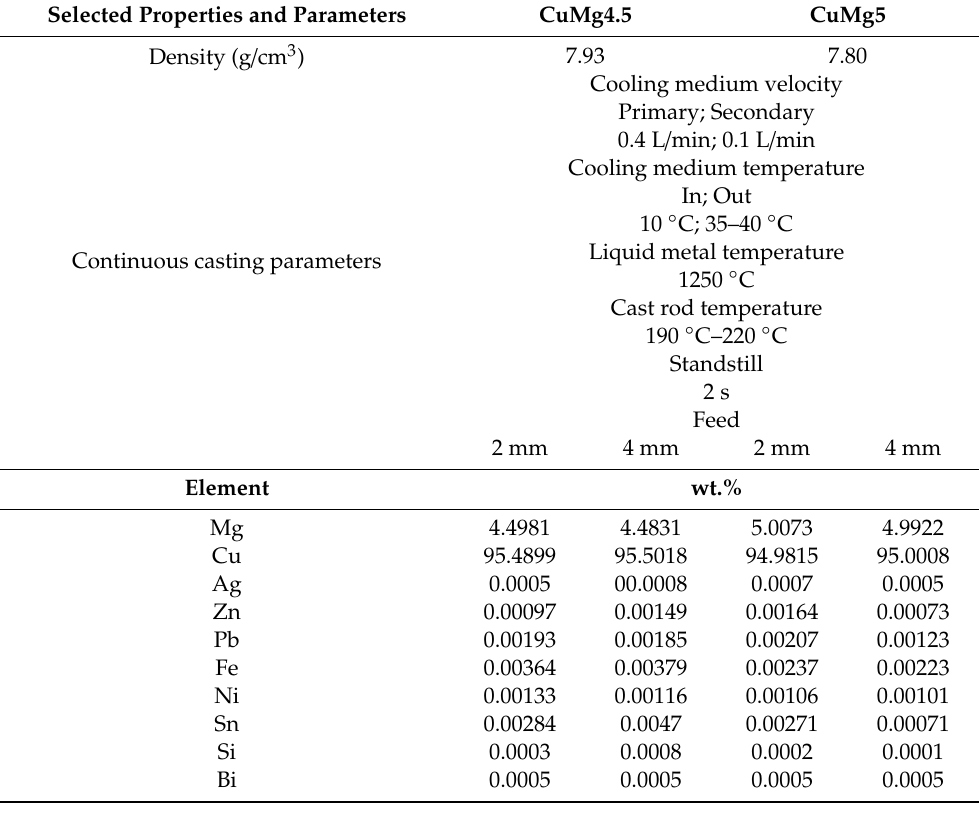
Table 1. Continuous casting parameters and chemical compositions of the obtained alloys. Selected Properties and